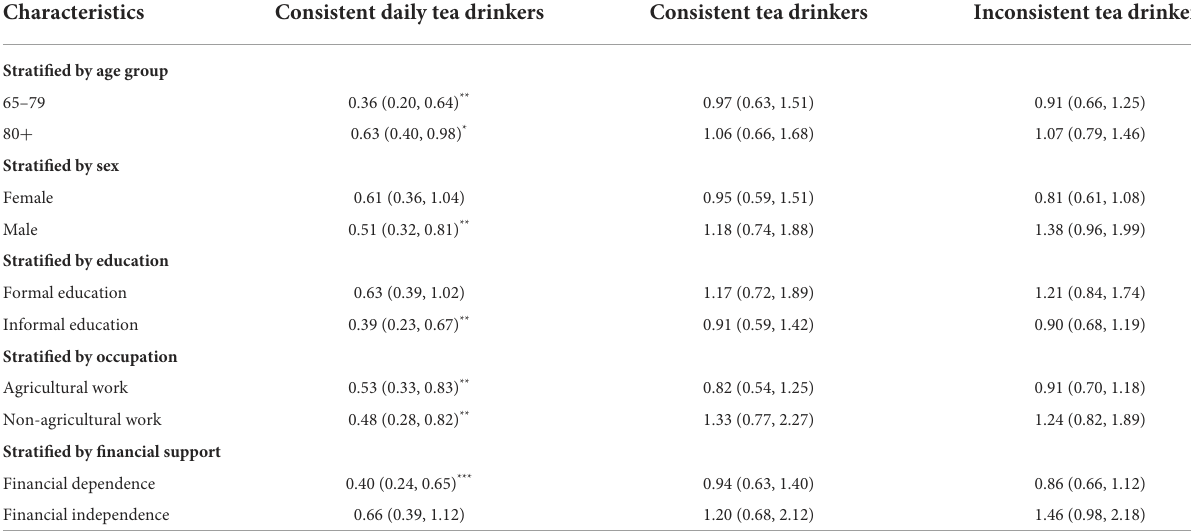
TABLE 3 The association between tea consumption and frailty stratified by age, sex, and socioeconomic status.